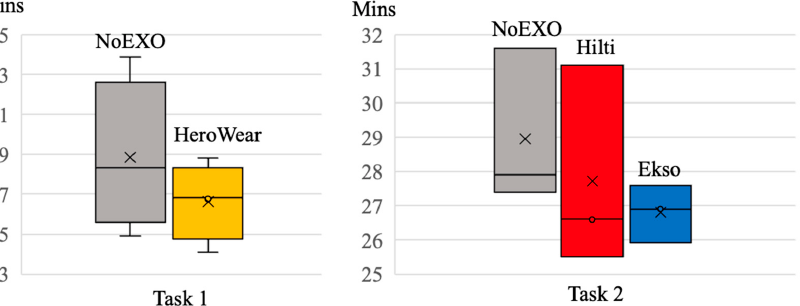
Figure 13. Completion time for Task 1 ( Left ) and Task 2 ( Right ).